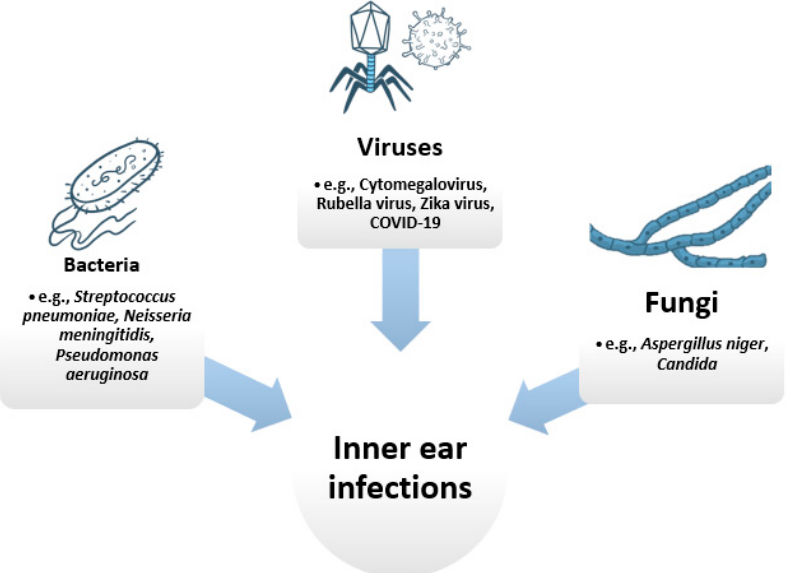
Figure 1. Main categories of pathogens causing inner ear infections. Created based on information from literature references [23–30].